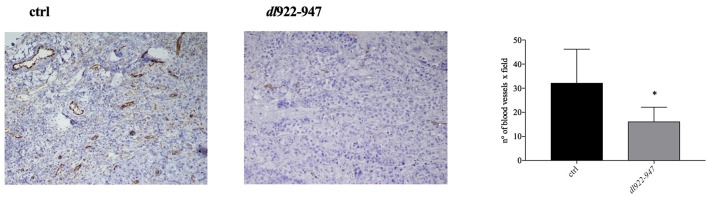
Histological analysis of CD31 expression. Tumor mass was collected to analyze CD31 endothelial marker presence. A representative image of control and dl922-947 treated mice is shown. The histogram reports the mean ± s.d. of TMD in tumor samples excised at day 32 treated as described above. TMD was determined as number of blood vessels x field. The statistical analysis was performed by Mann-Whitney t-test (*p < 0.05).